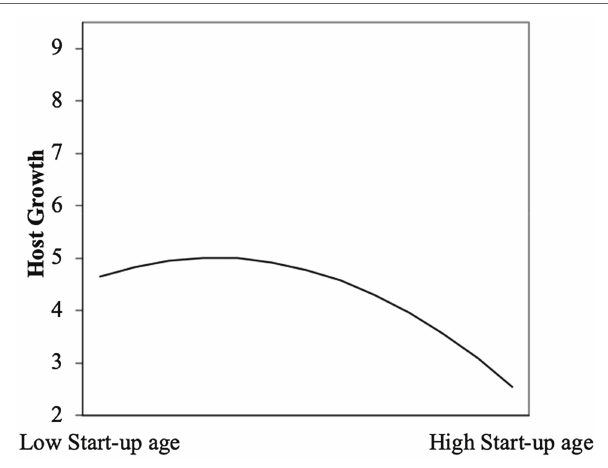
FIGURE 2 | The curvilinear relationship between start-up age and host